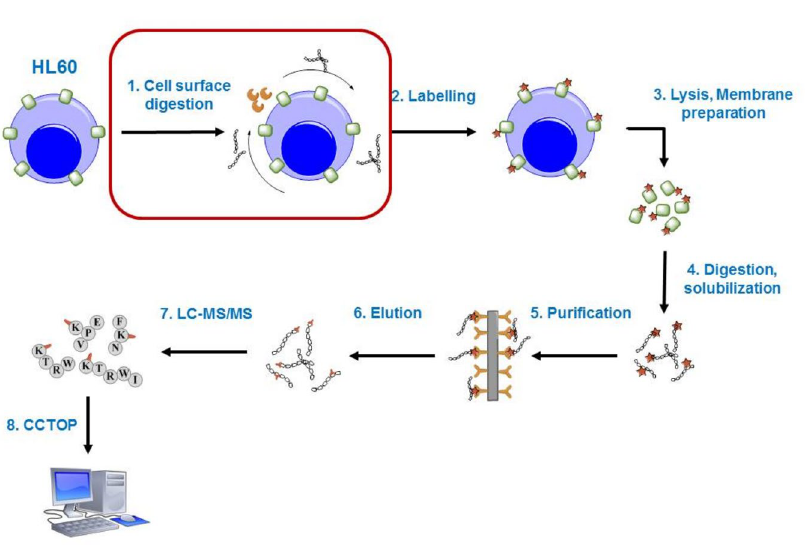
Figure 2. Flowchart of the new topology characterization method. Isolated cells are pre-digested by serine proteases (trypsin or chymotrypsin) and labelled with a membrane-impermeable, primary amino group- specific labelling agent (Sulfo-NHS-SS-biotin). The cells are lysed; plasma membranes are isolated, then solubilized and digested with proteomics-grade trypsin. The modified peptides are purified on a high-capacity neutravidin agarose resin, then eluted by reducing agent and sequenced by tandem mass spectrometry. Identified labelled positions can be used as extracellular constraints in the CCTOP topology prediction algorithm. The red rounded rectangle highlights the new step in the protocol compared to the previously published method 43